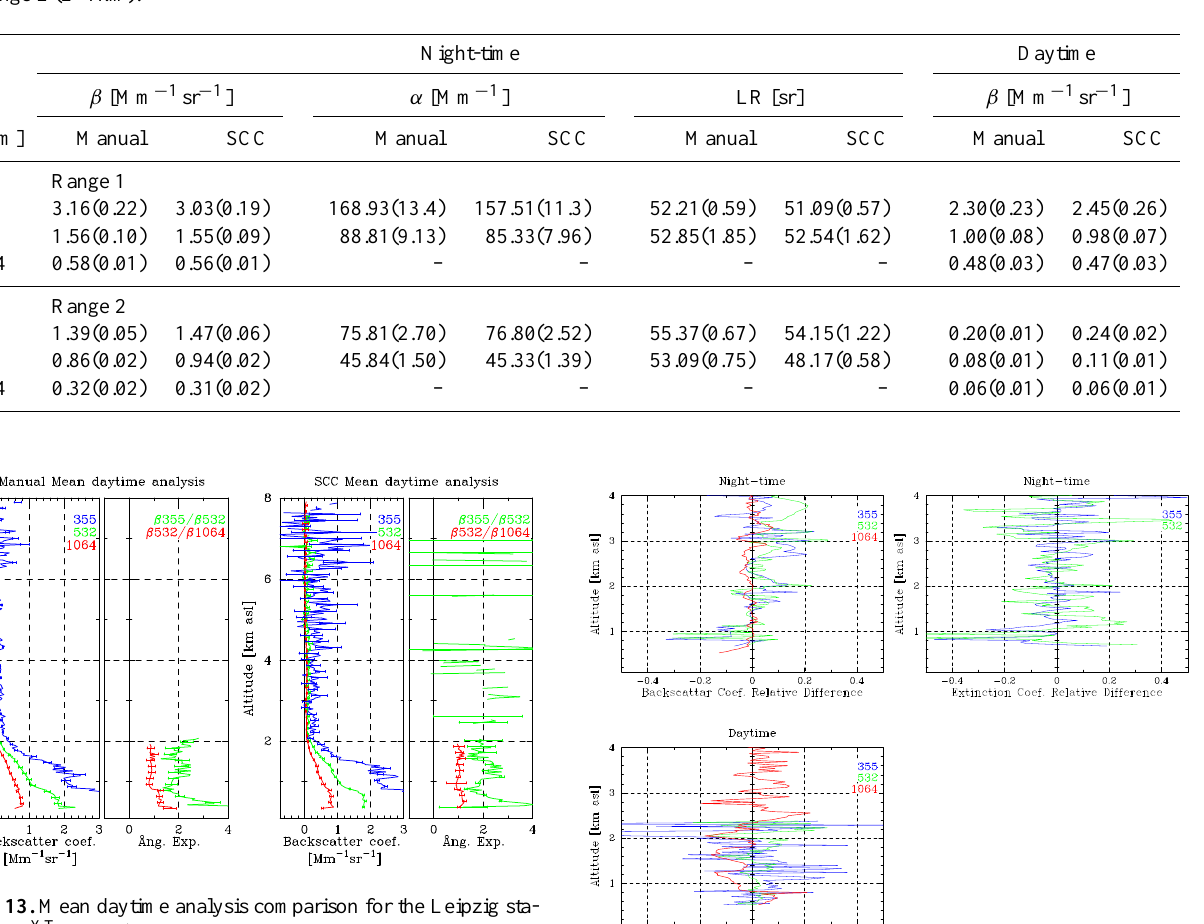
Table 4. Comparison of the mean values and standard errors of the mean for the profiles of the Leipzig station shown in Figs. 12 and 13. Mean values and standard errors of the mean (reported in parentheses) were calculated by averaging the mean profiles within Range 1 (0–2km) and Range 2 (2–4km).